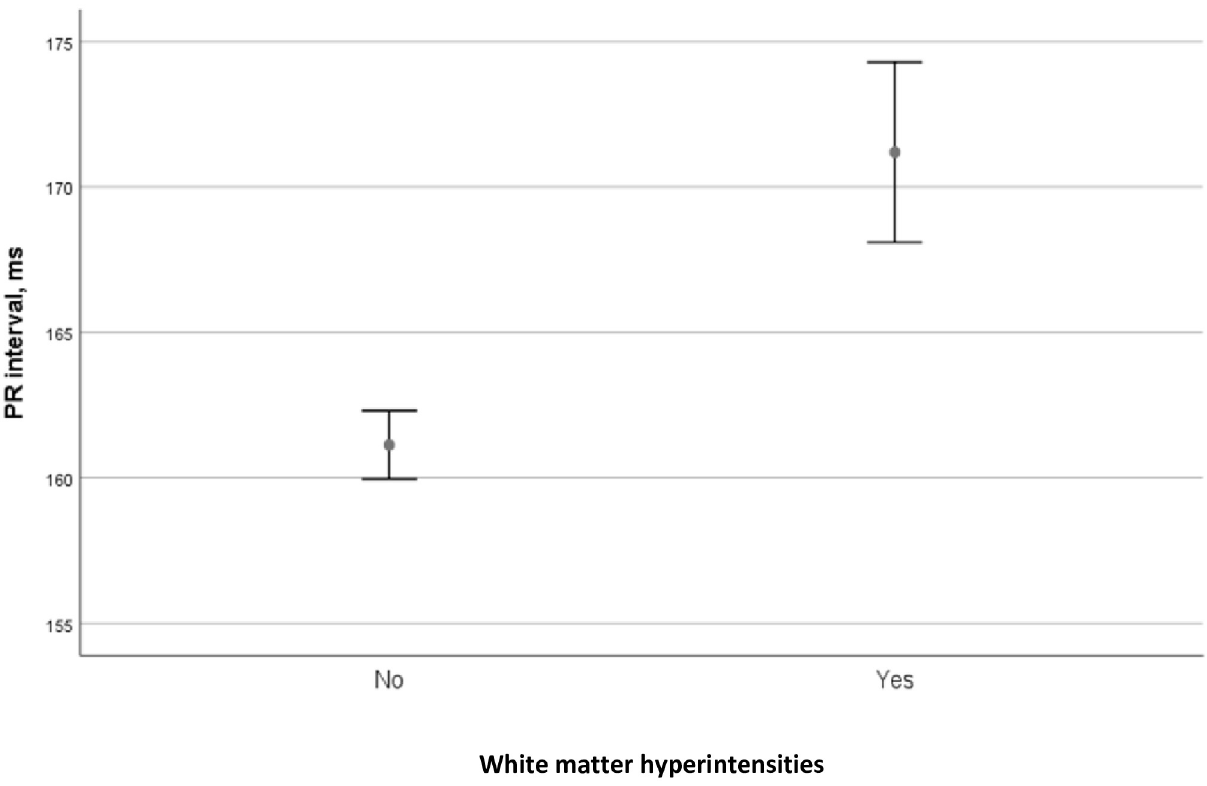
Fig 3. Association between PR interval duration and WMHs. The figure demonstrates association between white matter hyperintensities ( No — Fazekas stage 0–1, Yes —advanced Fazekas stages 2–3) and PR interval length.